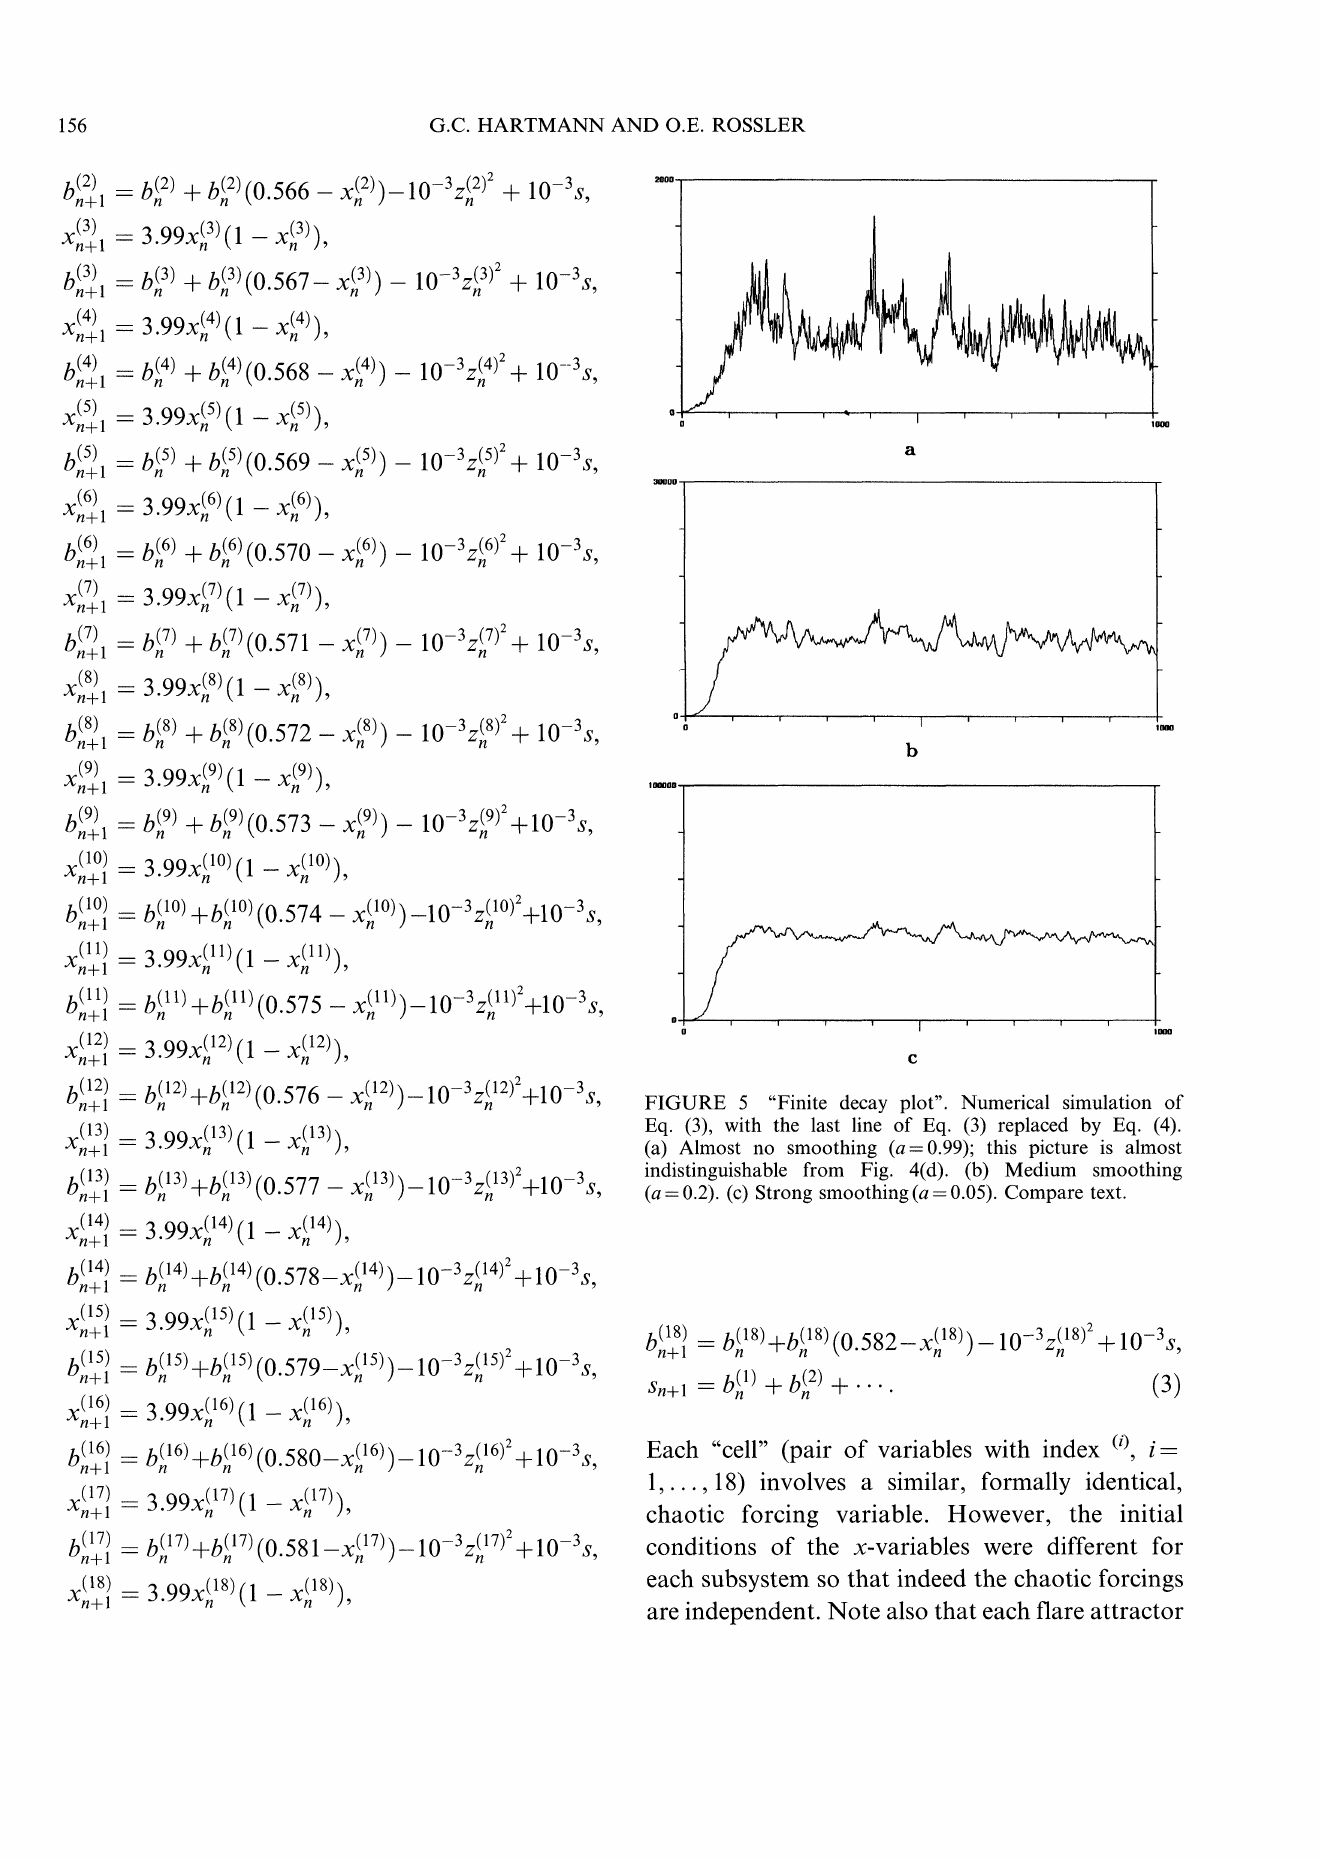
FIGURE 5 "Finite decay plot". Numerical simulation of Eq. (3), with the last line of Eq. (3) replaced by Eq. (4). (a) Almost no smoothing (a=0.99); this picture is almost indistinguishable from Fig. 4(d). (b) Medium smoothing (a 0.2). (c) Strong smoothing (a 0.05). Compare text.